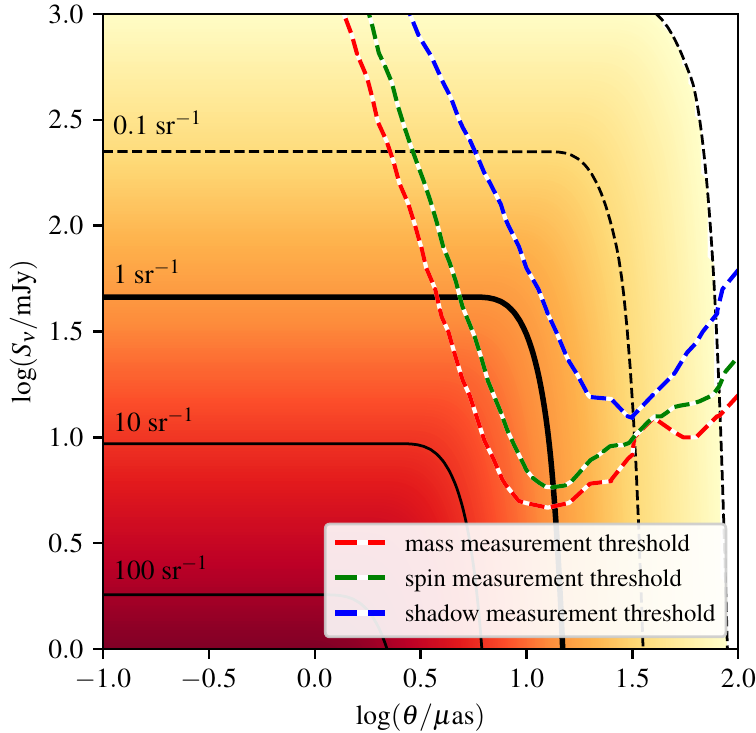
Figure 3. Approximate number density of SMBHs that are expected to satisfy different thresholds of measurability, assuming an observing frequency of 230GHz. The background colorscale and contours mark the number density (per unit solid angle) of SMBHs that have flux densities greater than S ν and shadow diameters larger than θ , as a function of S ν and θ and assuming that sources are distributed isotropically on the sky [19]. The solid contours start with the thick contour indicating a count of 1 and then increase by factors of 10 towards the lower left, while the dashed contours each decrease by a factor of ten towards the upper right. The overplotted colored dashed contours indicate where various parameters of interest could be measurable for different combinations of ( θ , S ν ) , assuming observations appropriate for the “full” ngEHT Phase 1 array observing at a declination of 10 degrees (i.e., averaged over right ascension). The red dashed contour marks the lower boundary of the region in which black hole mass can be measured, the green dashed contour marks the lower boundary of the region in which black hole spin can be measured, and the blue dashed contour marks the lower boundary of the region in which black hole shadow can be